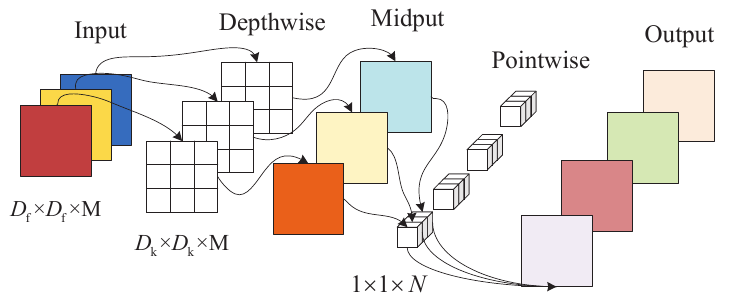
Figure 1. Depthwise separable convolution structure.